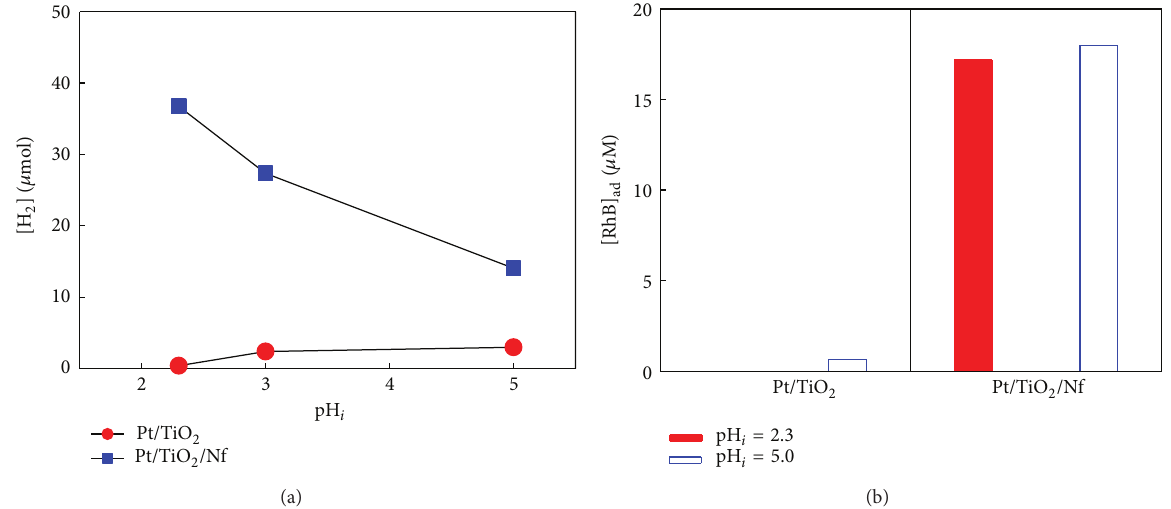
Figure 2: (a) Production of H 2 for 4 h and (b) adsorption of RhB in the suspension of Pt/TiO 2 and Pt/TiO 2 /Nf as a function of pH 𝑖 . Experimental conditions: [catalyst] = 0.5 g L −1 , [RhB] = 40 𝜇 M (for part (a)) or 20 𝜇 M (for part (b)), [EDTA] = 4mM, and 𝜆 > 420 nm (for part